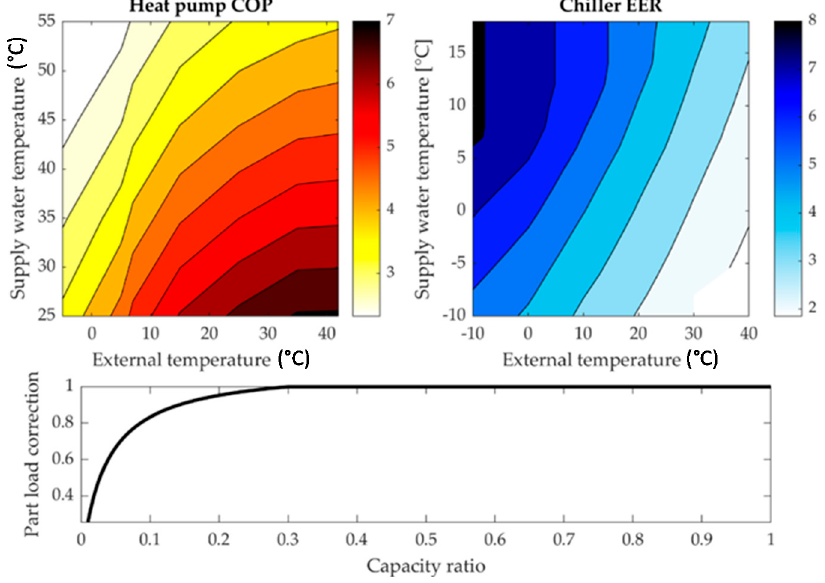
Figure 3. Heat pump and chiller nominal performance and part-load corrections.